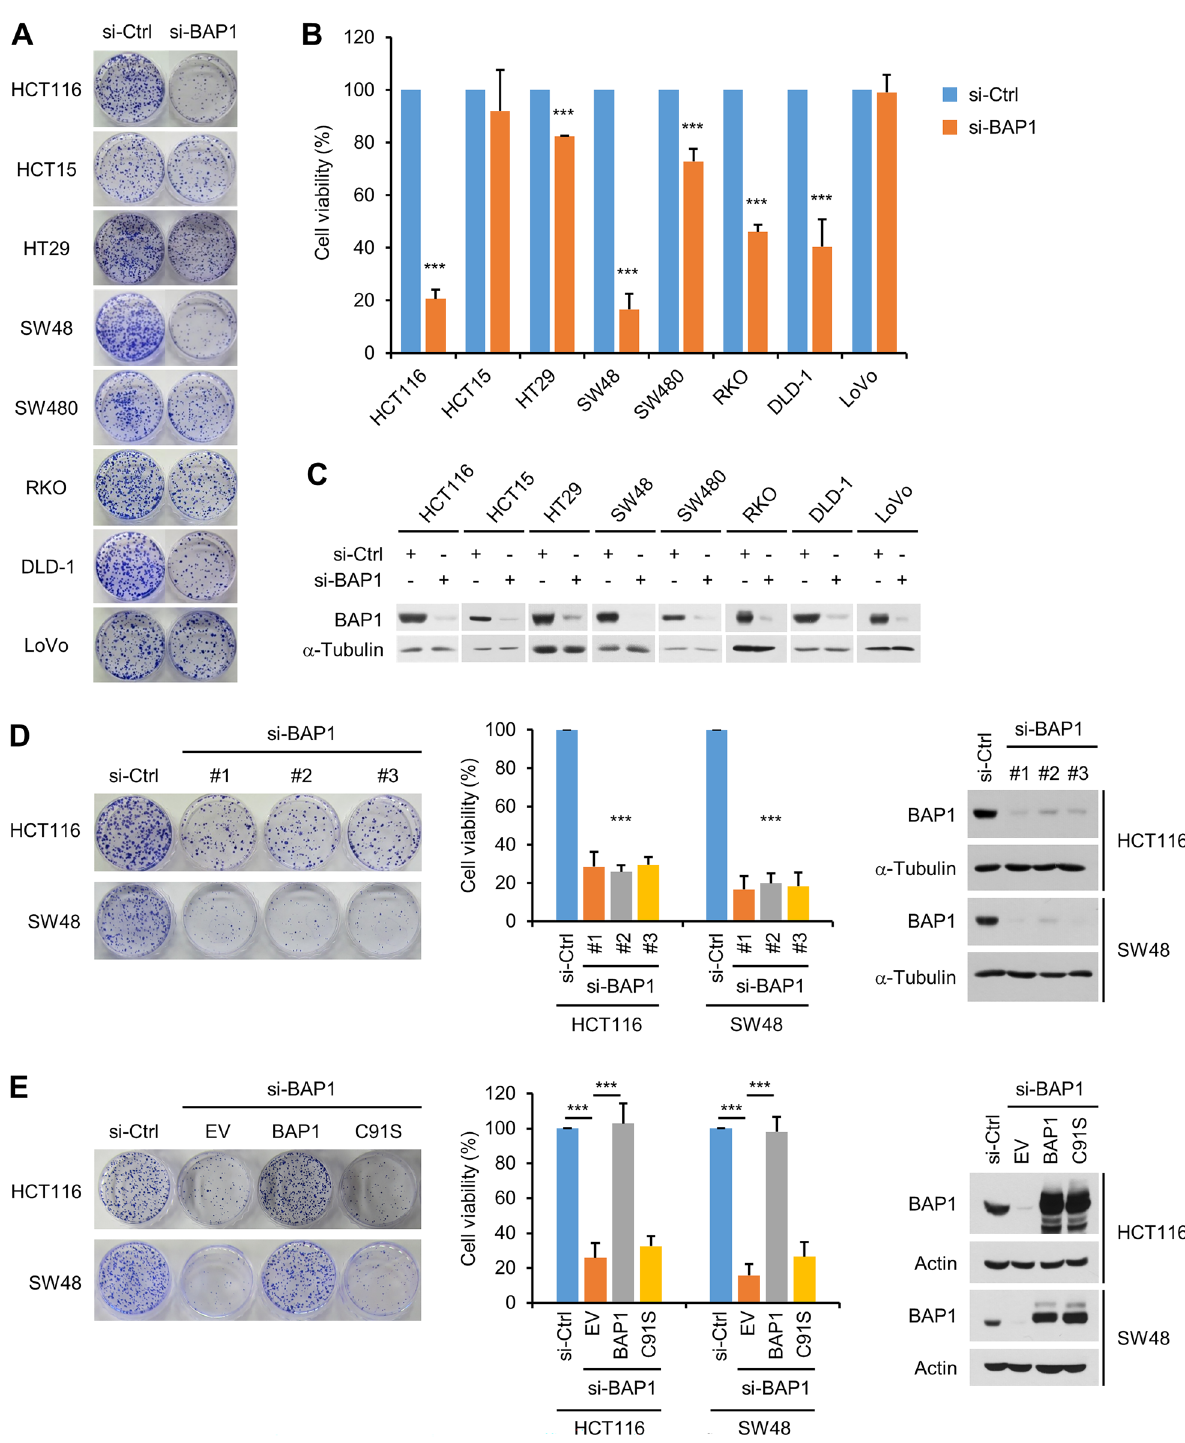
Figure 2. BAP1 is critical for the viability of various colon cancer cells. ( A ) Various colon cancer cells were transfected with control or BAP1 siRNAs and subjected to a colony formation assay. Representative results are shown. ( B ) The results of the colony formation assay are depicted graphically. n = 3 (each performed in triplicate, applicable to all colony formation assays in this paper); error bars, mean ± s.d. values. ( C ) Results of immunoblot analysis of BAP1 knockdown. α-Tubulin was used as the loading control. ( D ) (Left) Representative results of the colony formation assay in HCT116 and SW48 cells after BAP1 knockdown by three siRNAs targeting different sequences. (Middle) The results of the colony formation assay are depicted graphically. n = 3; error bars, mean ± s.d. values. (Right) Results of immunoblot analysis of BAP1 knockdown. ( E ) After HCT116 and SW48 cells were transfected with control or BAP1 siRNAs, the si-BAP1-transfected cells were transduced with an empty lentiviral vector (EV) or lentiviral vectors expressing wild-type or C91S mutant forms of Flag-BAP1, which were then subjected to a colony formation assay. (Left) Representative results of the colony formation assay. (Middle) Summary of the results of the colony formation assay. n = 3; error bars, mean ± s.d. values. (Right) Results of immunoblot